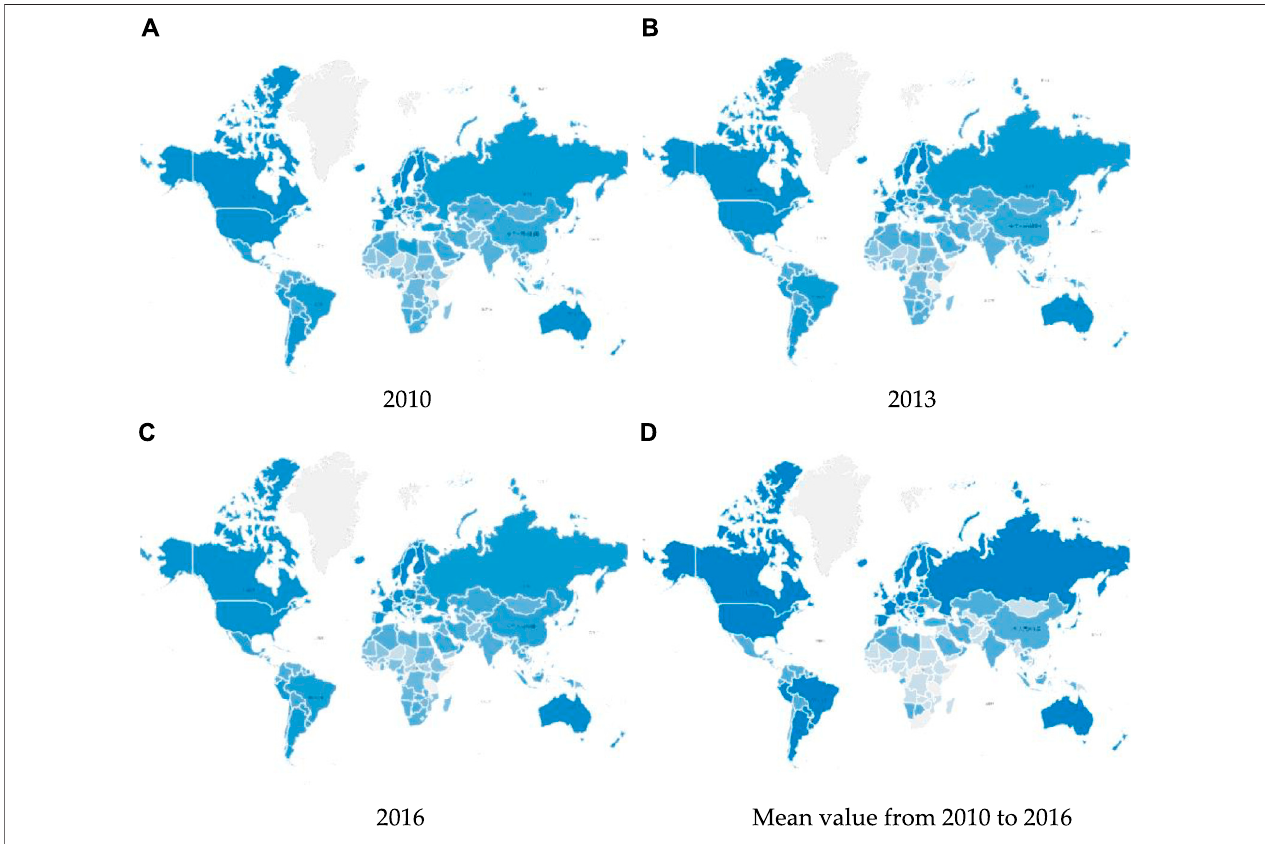
FIGURE 1 | Geographical distribution of NSDI. Note: (A) is the geographical distribution of NSDI in 2010; (B) is the geographical distribution of NSDI in 2013; Sub fi gure (C) isthegeographicaldistributionoftNSDIin2016; (D) isthegeographicaldistributionofthemeanvalueofNSDIfrom2010to2016,andhigh-NSDIcountries are dark blue, medium-NSDI countries are light blue, and low-NSDI countries are gray.